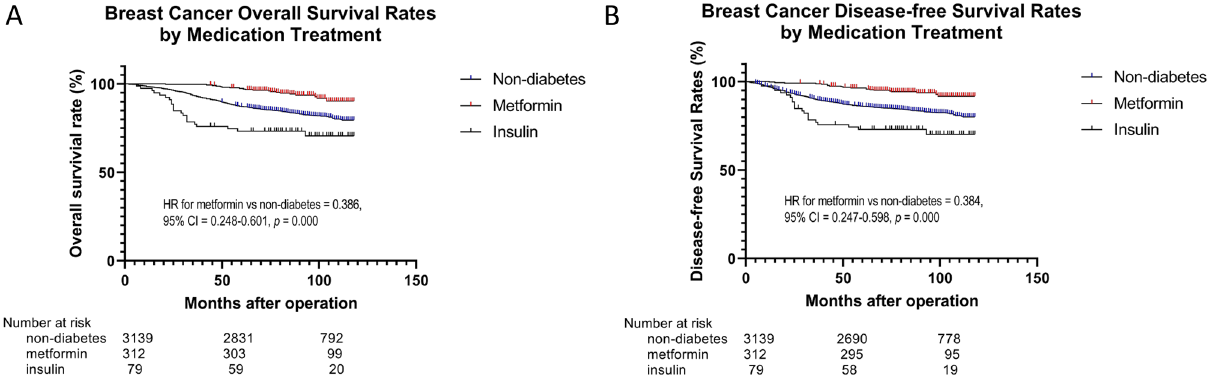
Figure 1. Kaplan–Meier survival estimate for OS ( A ) and DFS ( B ). DFS disease-free survival, OS overall